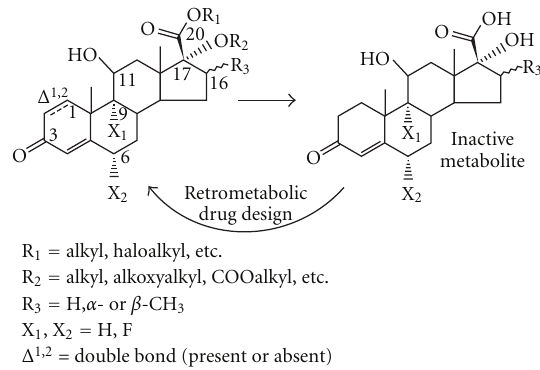
Figure 3: Retrometabolic design of cortienic acid-based derivatives adapted from